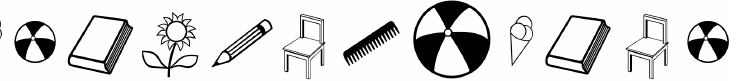
Figure 1. The experimental procedure for measuring speech perception with the word-to-picture matching task. The visual cue was displayed for 3000 ms, indicating the onset of the spoken target word presented over headphones. The target word was played over headphones 1500 ms after the onset of the visual cue. Thereafter, the response display was shown, which comprised four pictures, one representing the target word (here: Kopf (head)) and three representing phonologically similar distractor words (Topf (pot), Knopf (button), and Zopf (braid)).